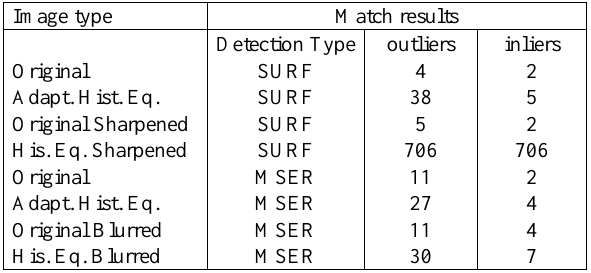
Table 3. Results of the experiment 2